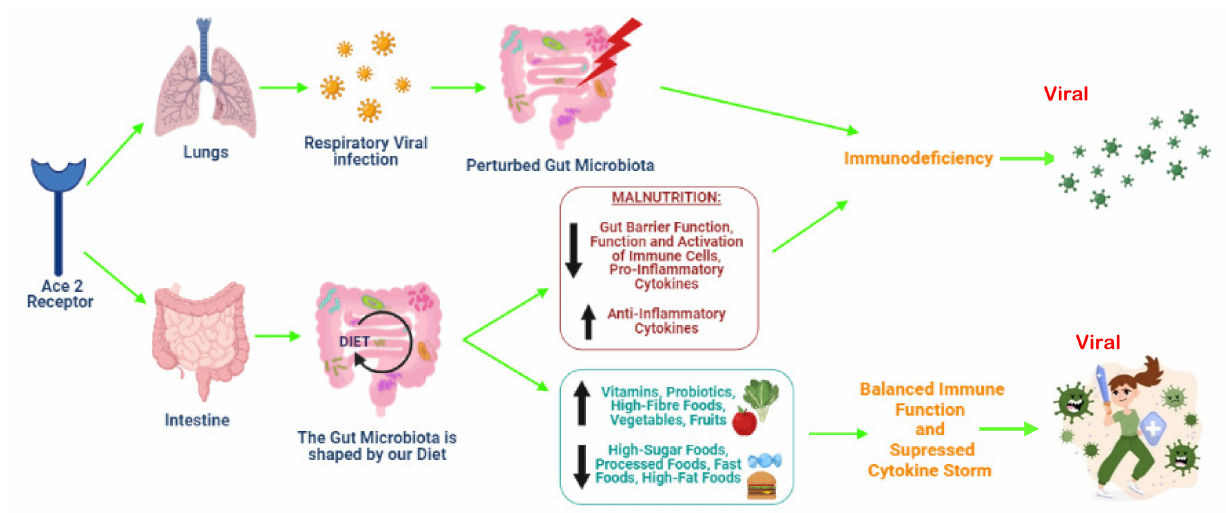
Figure 3. The impact of various nutrients and foodstuffs on the immune system of the host (created with BioRender.com, accessed on 25 October